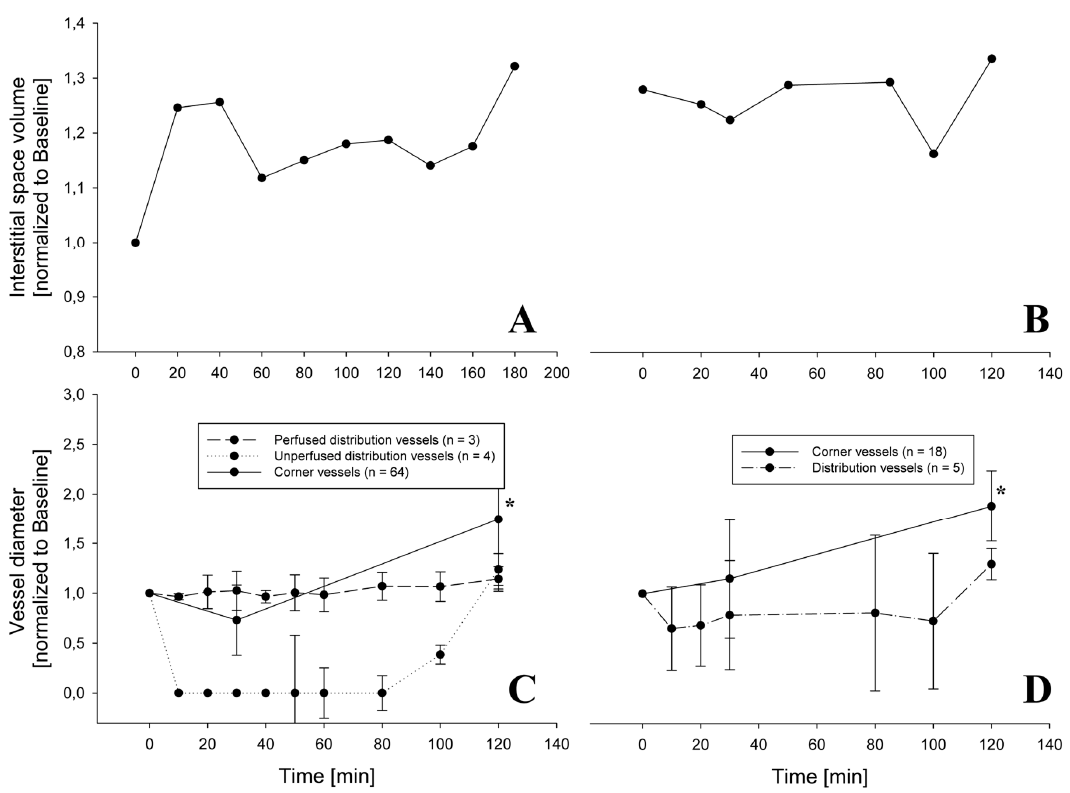
Figure 5. Change of interstitial space volume during hypoxia exposure for 2 different rabbits (Panels A , B ) and the relative change in diameter of distribution and corner vessels (Panels C , D ). In Panel C, distribution vessels have a diameter less than 100 µm and are distinguished among those which were always perfused and those which were closed at some timepoint. In Panel C , at all timepoints from 10 up to 100 min, the diameter was significantly decreased relative to baseline for the unperfused distribution vessels ( p < 0.001). The diameter of corner vessels steadily increased (* = p < 0.05).